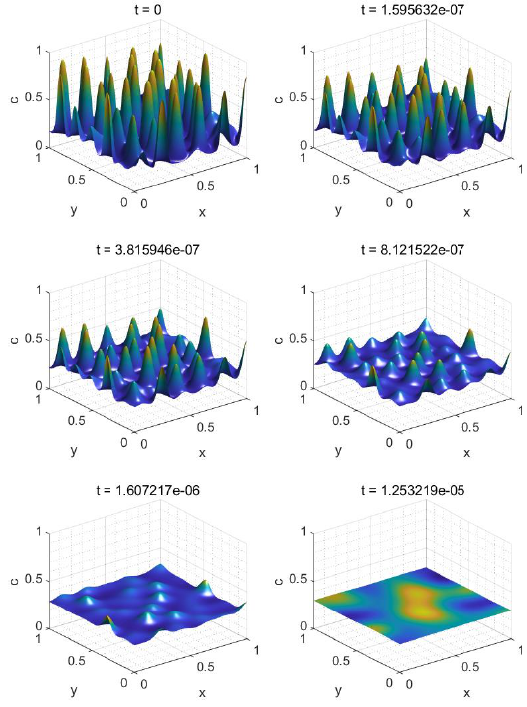
Figure 11. Dimensionless concentration spatial profiles c * ( x * , y * ) formed during the phase separation phenomena for the case where D = 10 5 , c o* = 0.3 and T * = 0.36. The asterisks were left out of the variables x , y , c , and t in the figure.